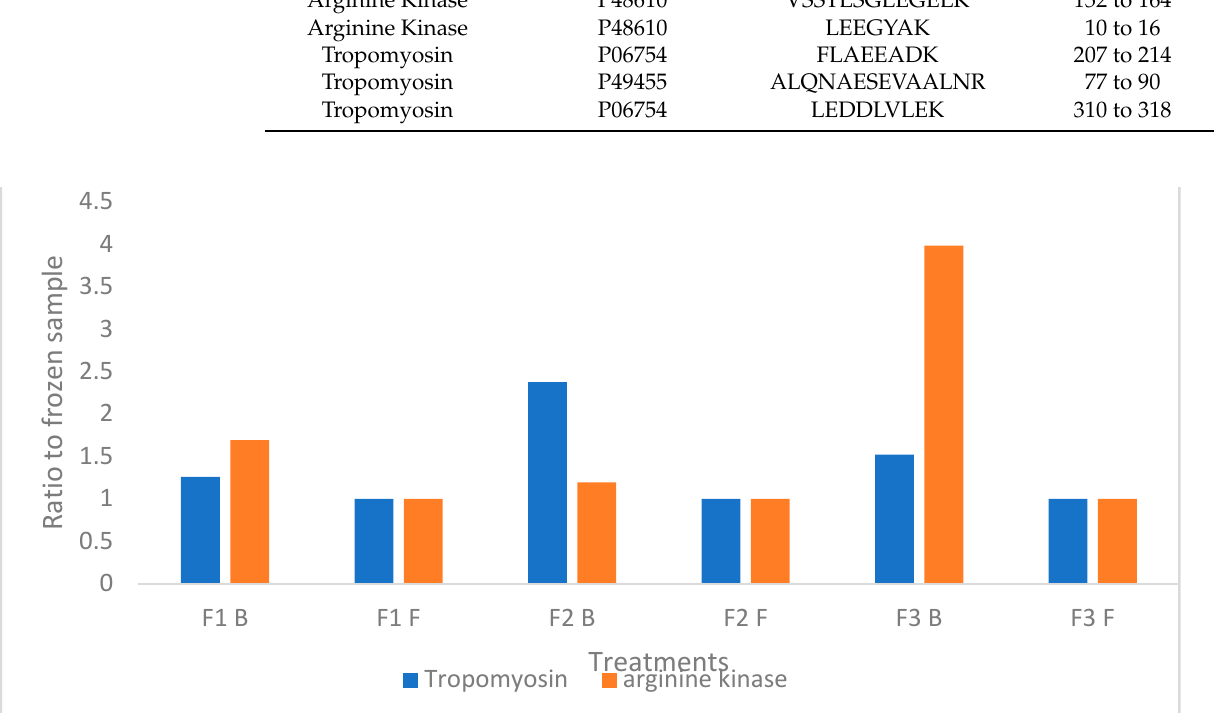
Table 6. Unique proteins and accession numbers identified in black solider fly larvae to be used to differentiate between black soldier fly larvae and crustaceans.